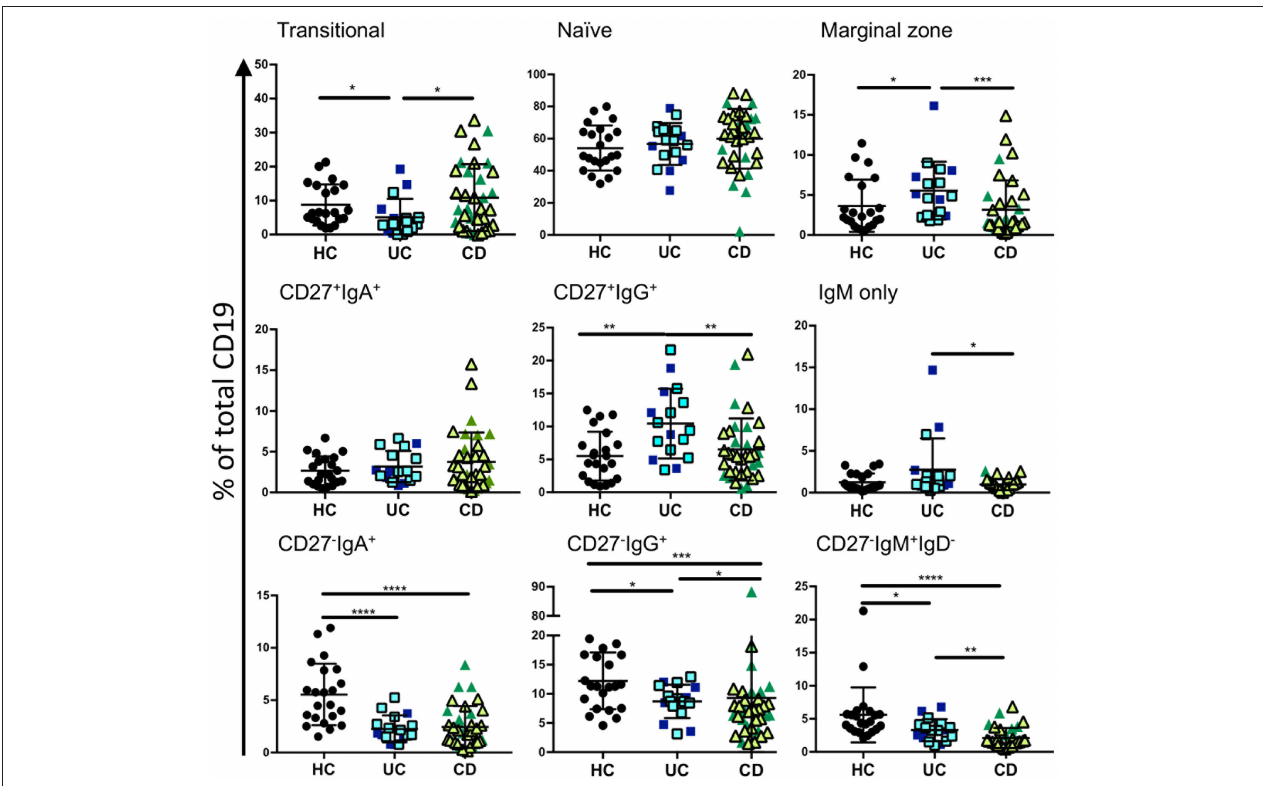
FIGURE 2 | Analysis of B cell subsets in healthy controls and IBD patients. Peripheral blood mononuclear cells from IBD and HC patients were stained using fluorescent antibodies and gated according to the strategy in Figure 1 and Supplemental Table 4 . Data is presented as percentage of total CD19 positive cells from each individual HC ( n = 22), UC patient ( n = 17), and CD patient ( n = 35). Patients with UC in are represented with blue symbols. Symbols that are lighter blue with black borders are patients in remission. Patients with CD in are represented with green symbols. Symbols that are lighter green with black borders are patients in remission. Differences between groups were analyzed by Mann-Whitney U test where p < 0.05 = *, p < 0.01 = **, p < 0.001 = ***, and p < 0.0001 =